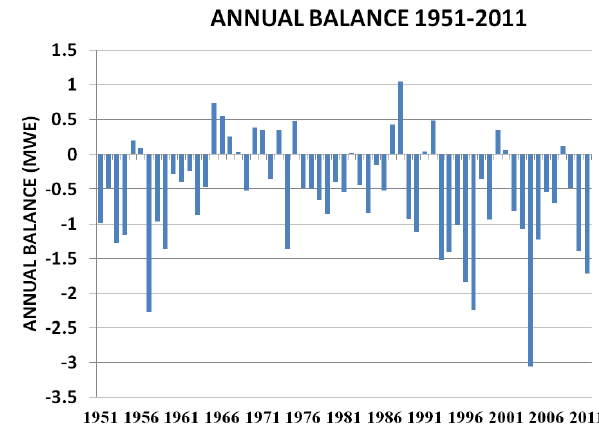
Figure 3 . Mean annual balance versus iteration number of the 203 Fig. 3. Mean annual balance versus iteration number of the op- optimizing simplex. Balances 1-15 are derived from preset coefficients. 204 timizing simplex. Balances 1–15 are derived from preset coeffi- Balances 16-400 are calculated automatically from coefficients 205 cients. Balances 16–400 are calculated automatically from coeffi- cients determined by the simplex optimizing process. When the cal- error reached a minimum, the average annual balance is -0.6 mwe, or 207 ibration error reached a minimum, the average annual balance was 9 − 0.6mw.e., or − 26.4km 3 for the 1951–2011 period. (www.ptaagmb.com). 219 220